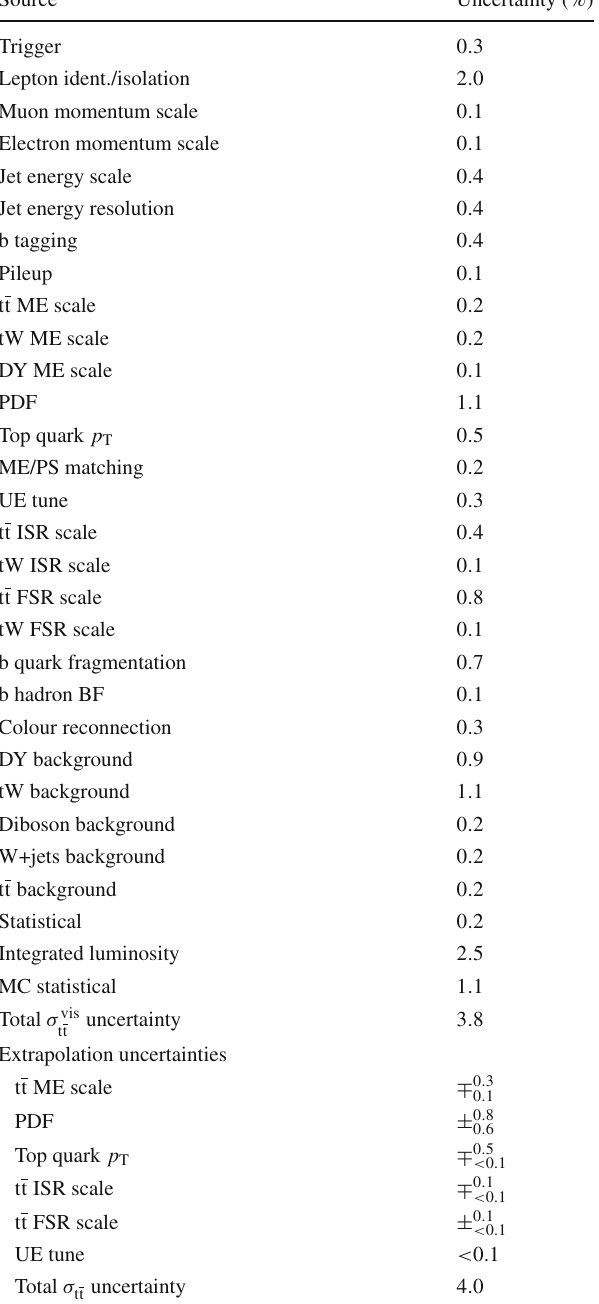
Table 1 The relative uncertainties in σ vis and σ tt and their sources, as tt obtained from the template fit. The uncertainty in the integrated lumi- nosity and the MC statistical uncertainty are determined separately. The individual uncertainties are given without their correlations, which are however accounted for in the total uncertainties. Extrapolation uncer- tainties only affect σ tt . For these uncertainties, the ± notation is used if a positive variation produces an increase in σ tt , while the ∓ notation